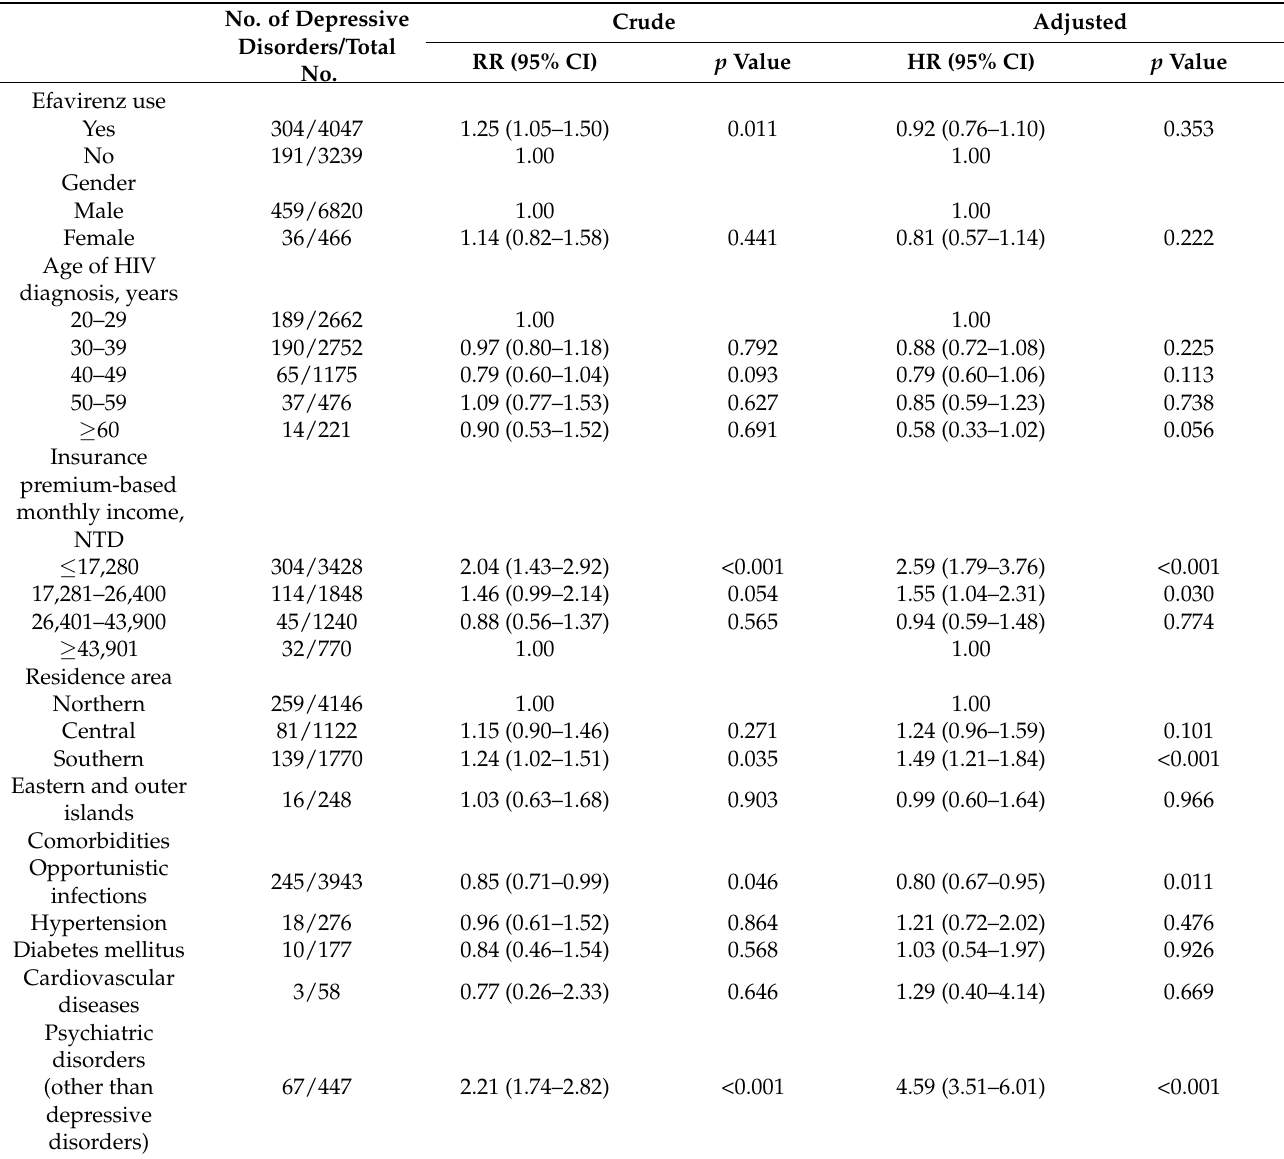
Table 2. Cox proportional hazard model for hazard ratio of depressive disorder onset among 7286 HIV-infected patients. No. of